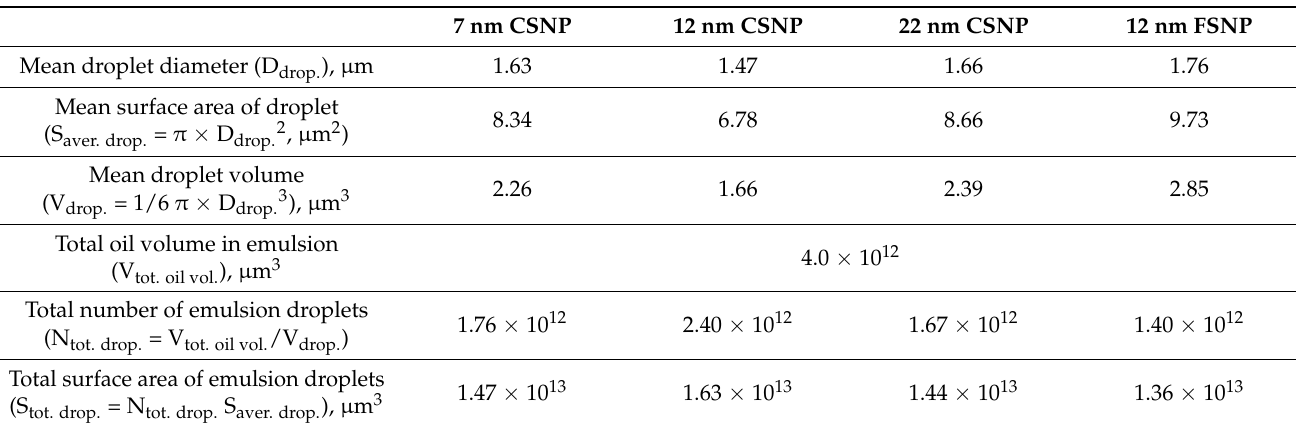
Table 1. Mean surface area per